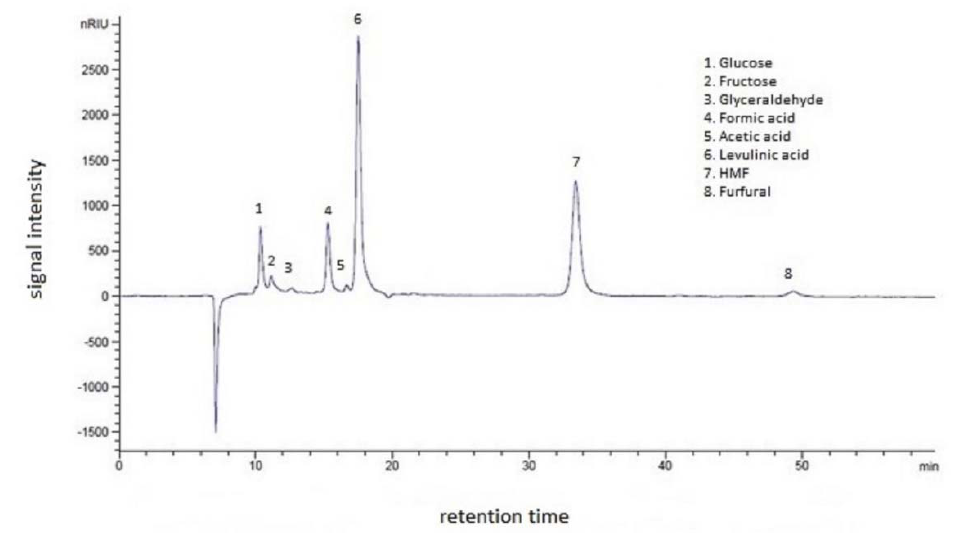
Figure 5. Typical HPLC spectrum of a reaction product of the reaction of inulin with CuCl 2 in aqueous